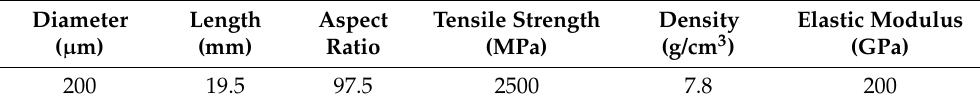
Table 2. Physical and mechanical properties of steel fibers.